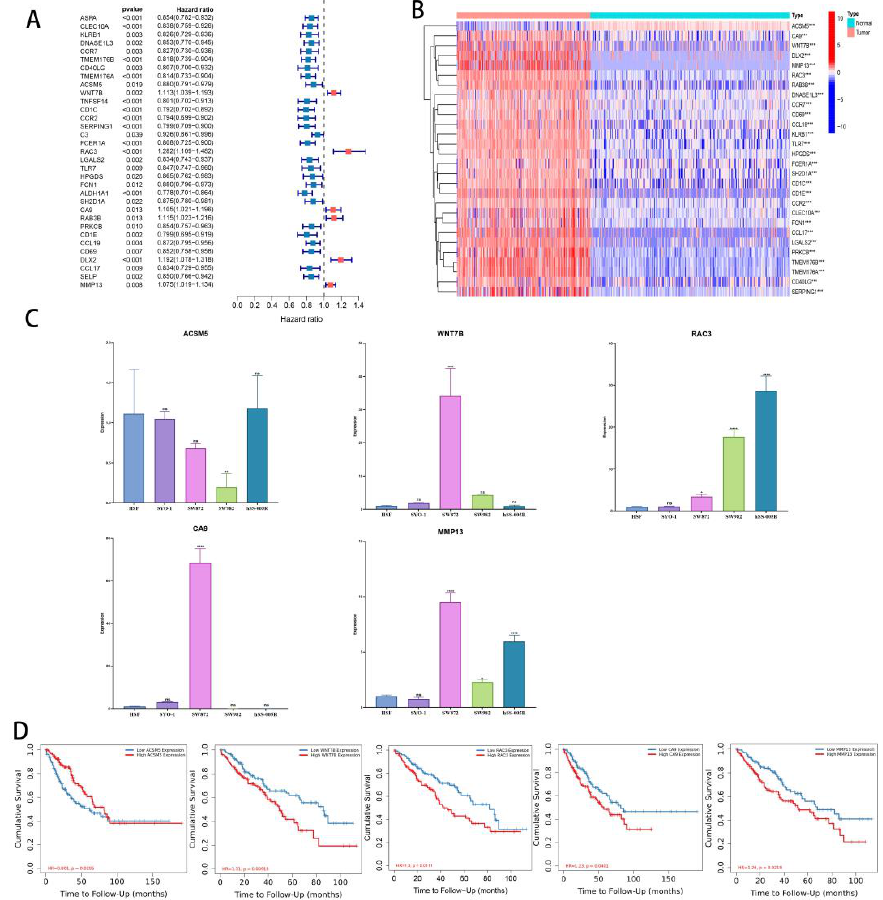
Figure 8. Identification of key DEGs. ( A ) Forest map of prognostic-related DEGs. ( B ) Heatmap of differential gene expression related to prognosis in normal tissues and tumors ( C ) Validation of ACSM5, WNT7B, RAC3, CA9, and MMP13 expression in cell lines by using RT-qPCR. ( D ) KM curves of TCGA-SARC patients divided by ACSM5, WNT7B, RAC3, CA9, and MMP13. ns, p ≥ 0.05; *, 0.01 ≤ p < 0.05; **, 0.001 ≤ p < 0.01; ***, 0.0001 ≤ p < 0.001; **** p < 0.0001.